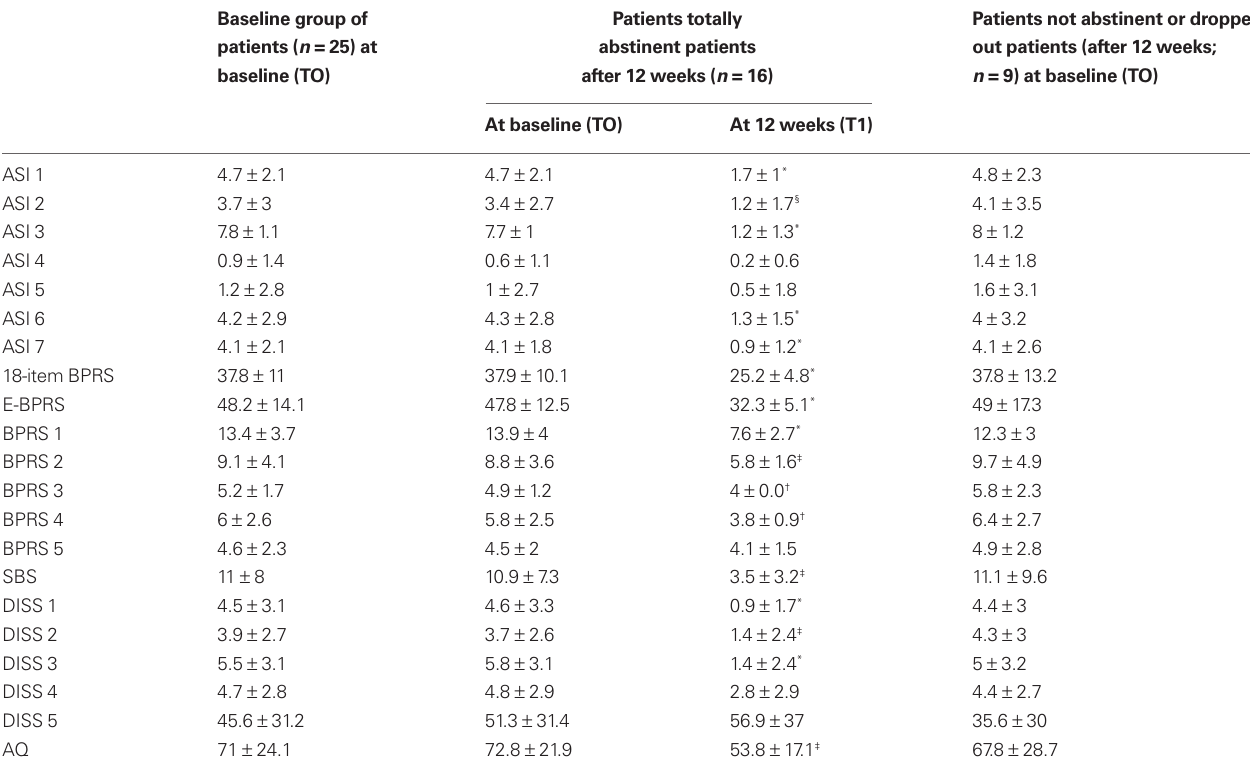
Table 3 | Psychometric tests in the baseline group of 25 patients, in the 16 patients totally abstinent after 12 weeks (both at baseline and at 12 weeks) and in the nine patients that were not abstinent during the 12-week period or dropped